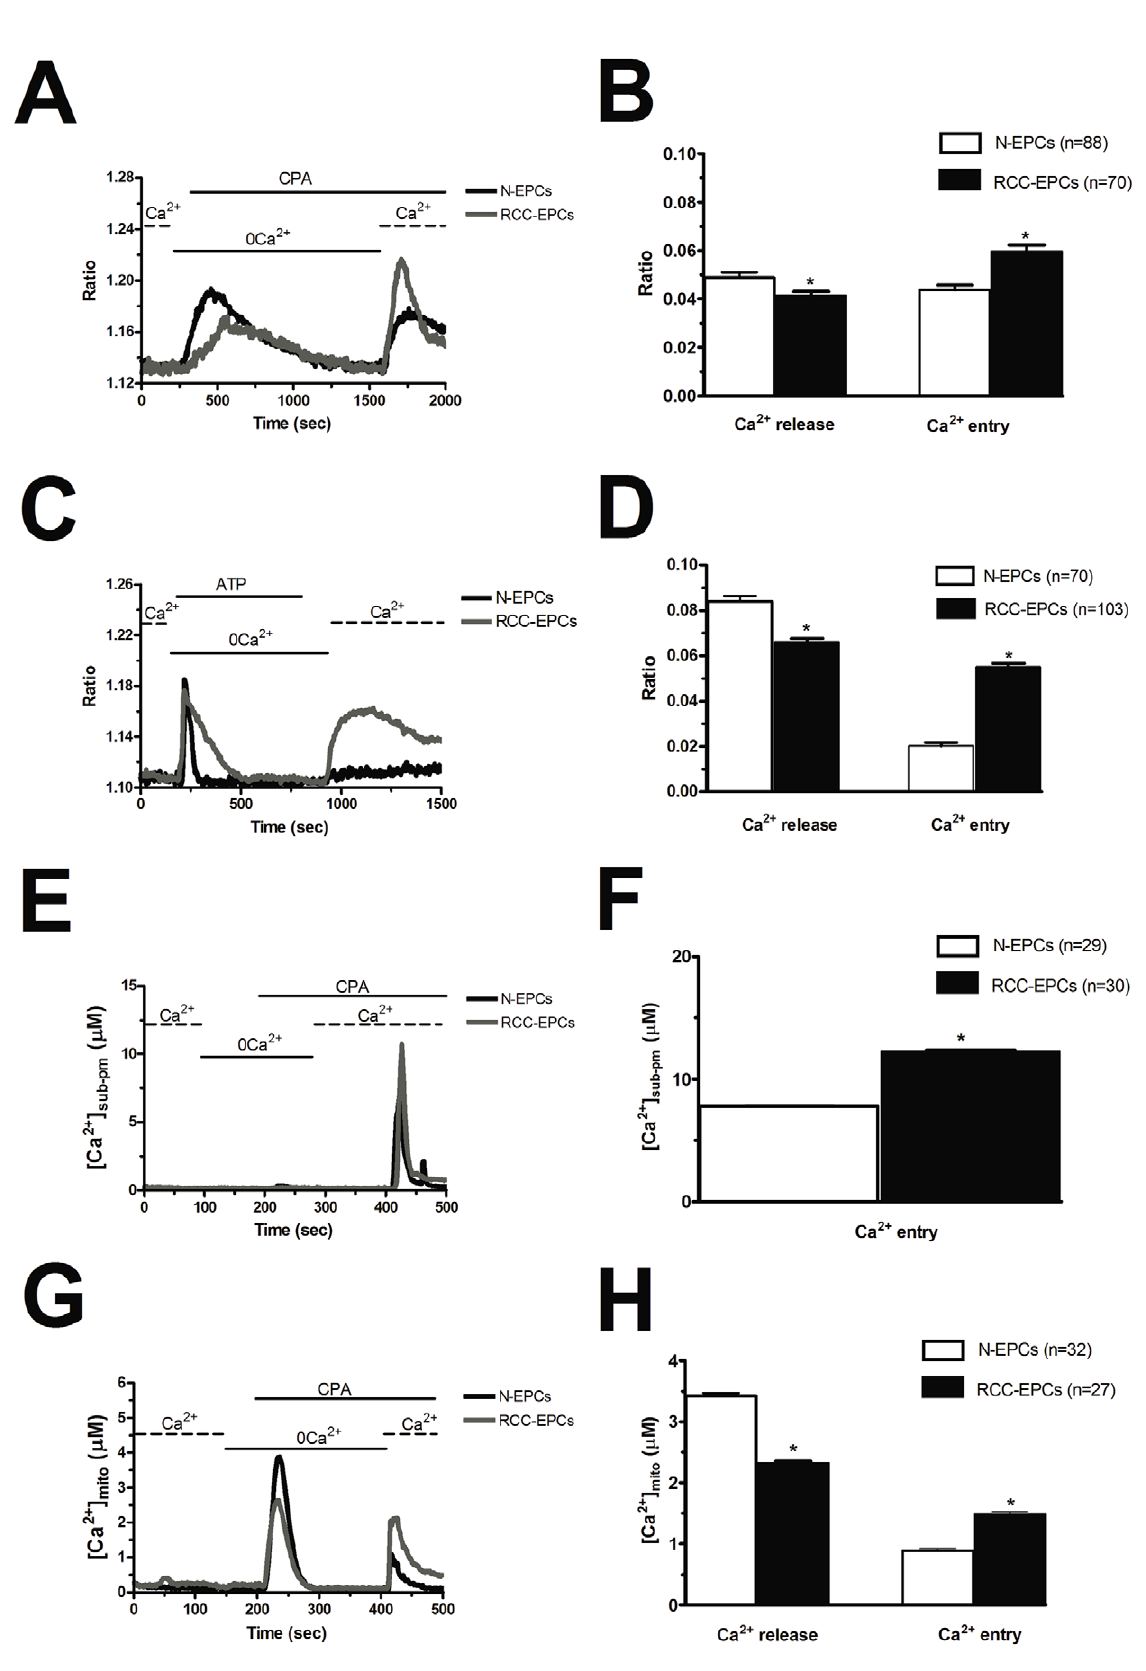
Figure 1. Store-dependent Ca 2 + entry is higher in endothelial progenitor cells isolated from patients suffering from renal cellular carcinoma. A, during exposure to 0Ca 2 + PSS, depletion of the intracellular Ca 2 + stores resulted from addition of 10 m M CPA to the bathing medium.